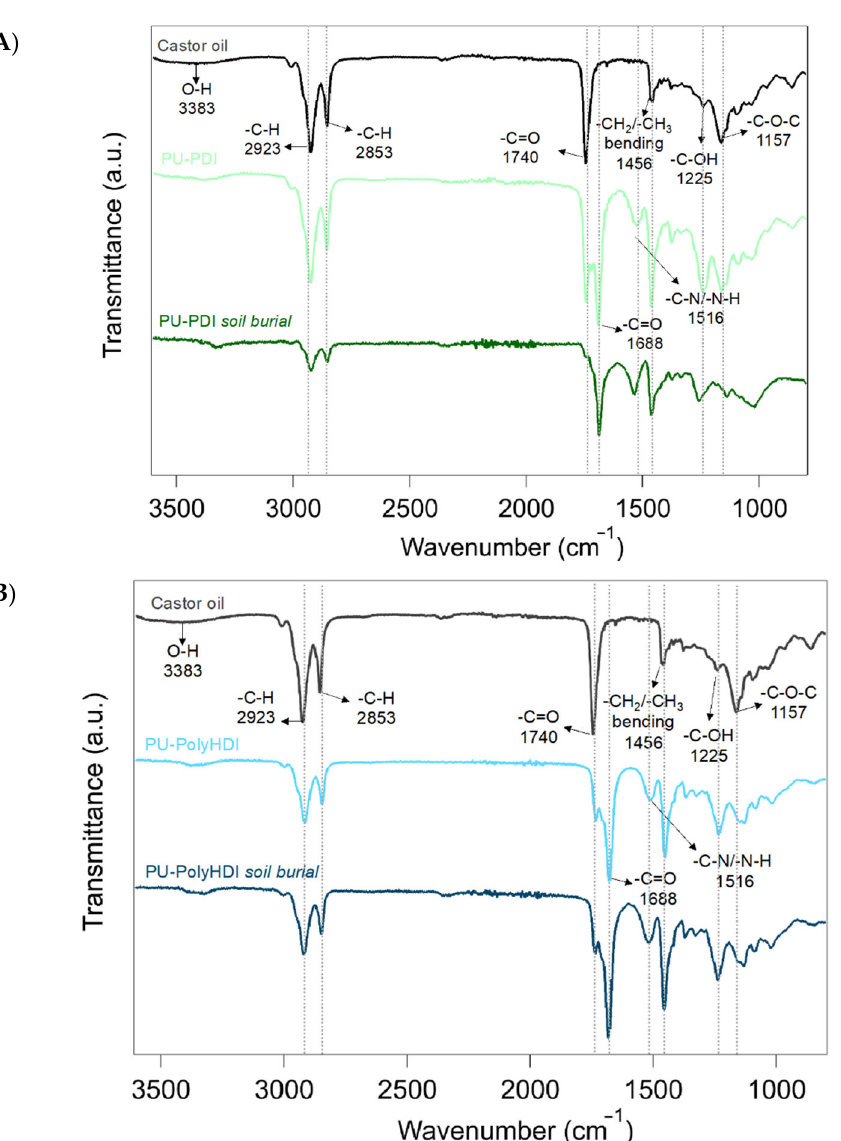
Figure 5. ATR ‐ FTIR adsorption spectrum of castor oil and adsorption spectra of samples before and after soil burial tests. ( A ) PU ‐ PDI and ( B ) PU ‐ PolyHDI.